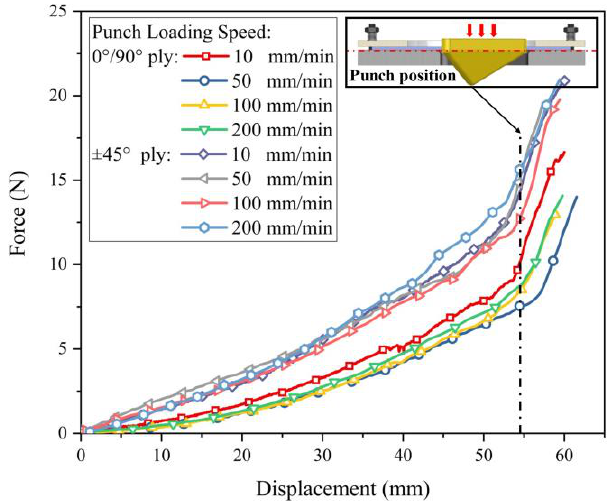
Figure 14. Punch force of reinforcements with 0°/90° and ±45° initial yarn orientations at different forming speeds.